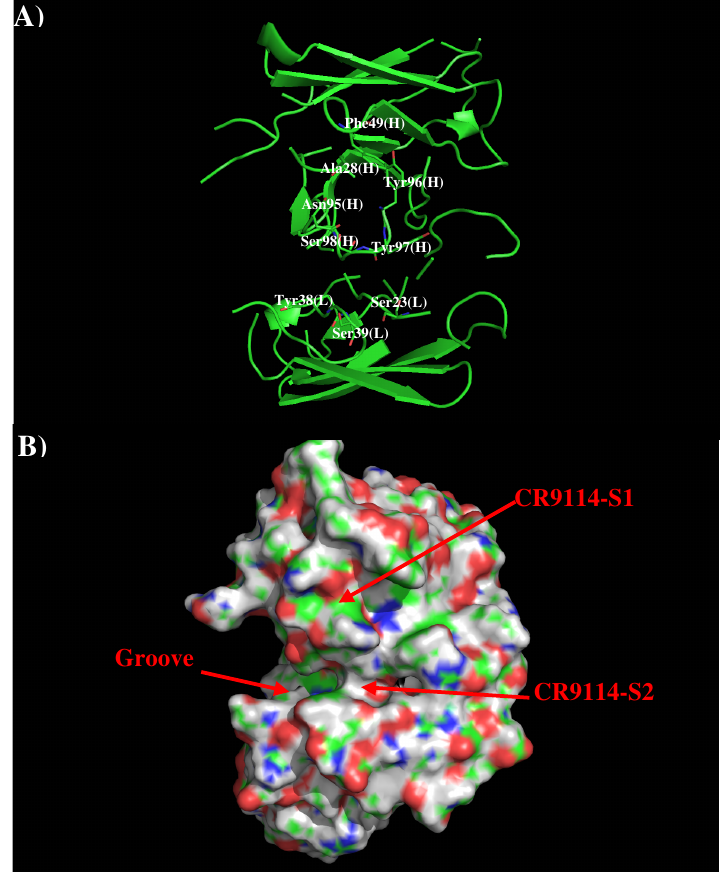
Figure 4. Model structure ( A ) and surface representation ( B ) of antibody CR9114. The important residues for the antibody interaction are shown in stick form in ( A ). (L) and (H) denote the VL and VH domain of the antibody respectively. The figure was prepared using PyMOL